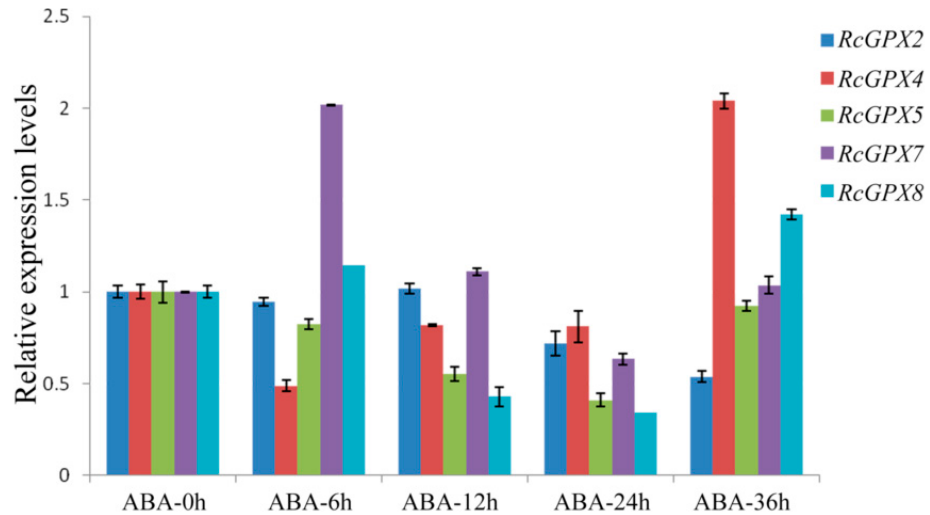
Figure 6. Time-course expression levels of RcGPXs genes for leaves under abscisic acid treatment. Plant hormone abscisic acid (ABA) was used to treat whole seedlings of R. crenulata at 50 μ M. Five time periods of conditions were selected at 0 h, 6 h, 12 h, 24 h, and 36 h. The total RNA was extracted from young leaves. mRNA levels were normalized with respect to RcGAPDH and were expressed relative to the values at 0 h (control), which were given an arbitrary value of 1. Data represent the means ± SE of at least three replicates.